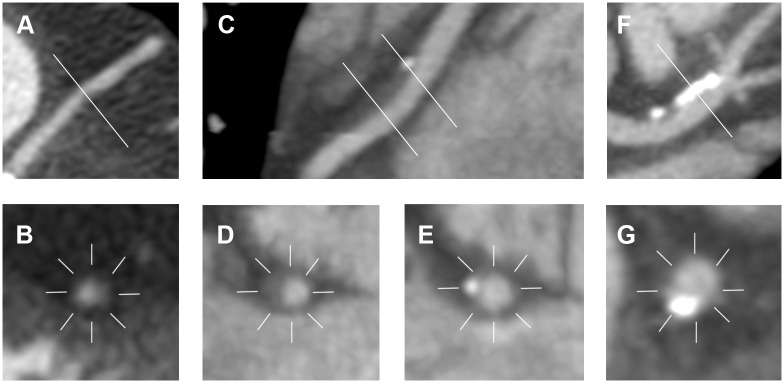
Different plaque types, as seen by cardiac computed tomography.A non-calcified plaque is shown in longitudinal and cross section (A and B). The degree of stenosis was 20–50%. A large mixed plaque is shown in longitudinal section (C) and in cross section at the level of non calcified (D) and calcified (E) components. A large calcified plaque is shown to the right. (F and G). The mixed and calcified plaques (C to G) were both eccentric in location and the degree of stenosis was <20%.